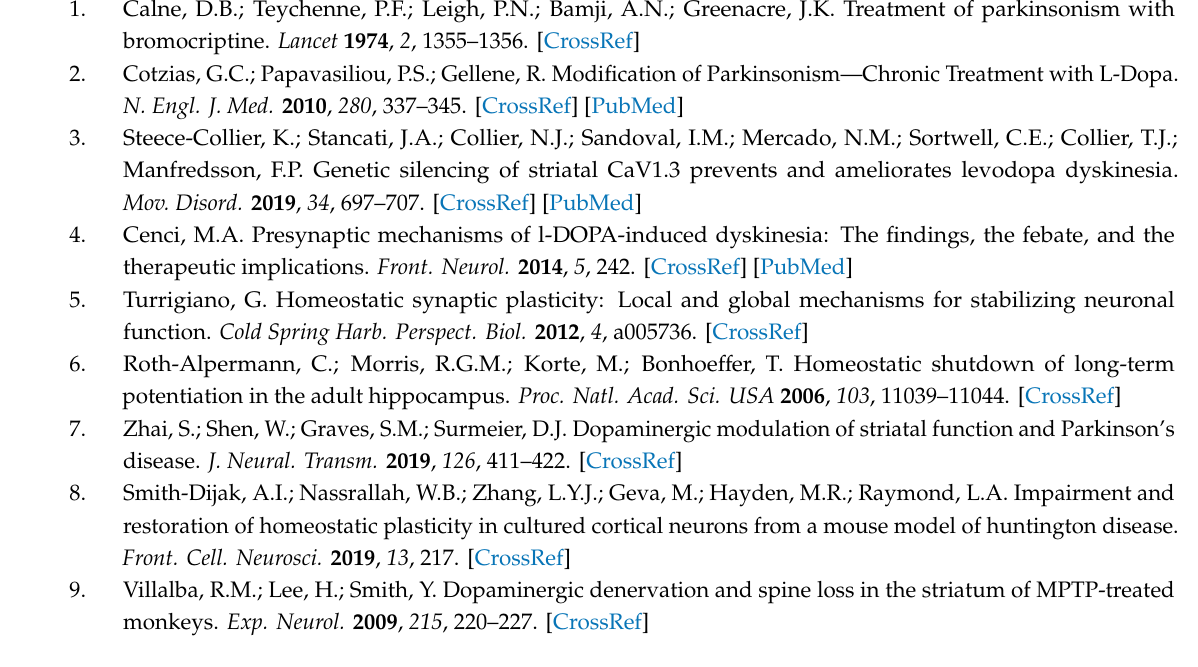
Figure S1: Per-animal analysis of MSN morphology 21 days after